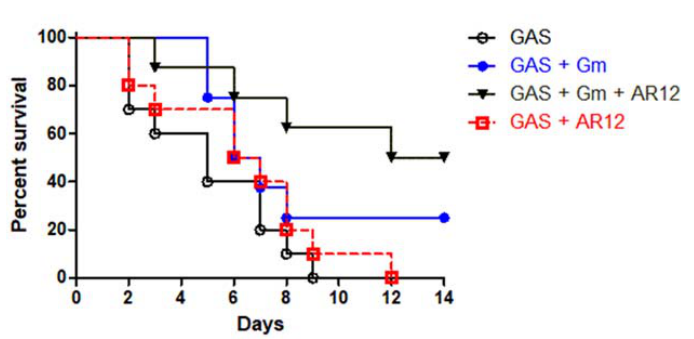
Figure 7. Combination of sub-MICs of gentamicin and AR-12 protected mice from lethal dose of group A streptococcal infection. Groups of eight to ten mice were inoculated via the air pouch route with 2 × 10 8 CFU of GAS NZ131 strain. After the GAS inoculation, an air pouch injection of 2 μ g/kg of gentamicin, 10 μ g/kg of AR-12, or the same dosage of gentamicin-AR-12 combination was administered immediately post GAS infection. The animals were observed every day for a total of 14 days. The survival curves were compared for significance using the log-rank test for the drugs treatment groups versus the GAS-infected mice ( p < 0.01).